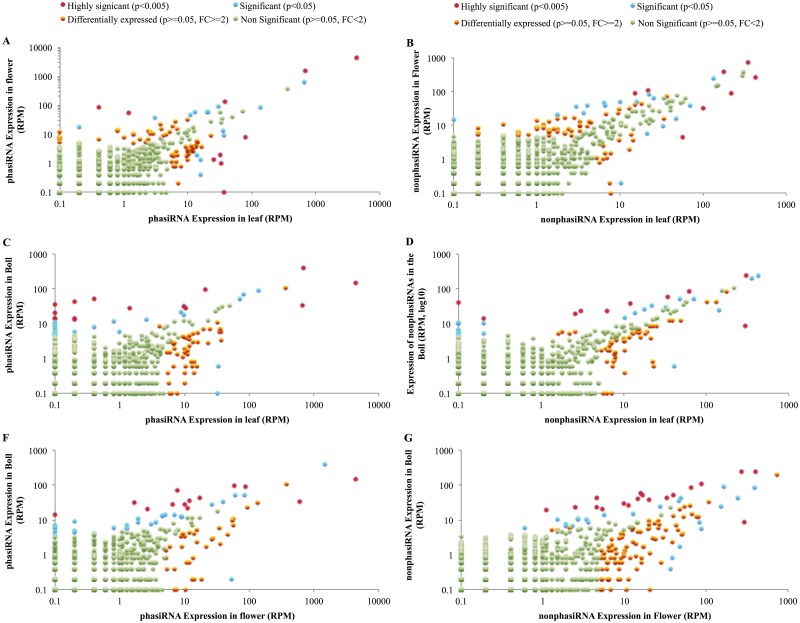
Expression changes of phased and non-phased siRNAs among the three tissues examined.The expression changes of phased and non-phased siRNAs between different tissues are shown. The expression changes for phasiRNAs are shown in Panel A, C, and E, and the expression changes for non-phased siRNAs are shown in Panel B, D, and E. The siRNA sequences with p< 0.005 and p<0.05 are shown in red and blue, respectively. Those sequences with FDR p ≥0.05, which are expressed at higher levels (≥5 RPM) and are regulated at least 2 fold changes, are shown in orange, while the siRNA sequences with FDR p ≥0.05, which are not expressed at higher levels (< 5RPM) or are not regulated less 2 fold changes, are shown in green.